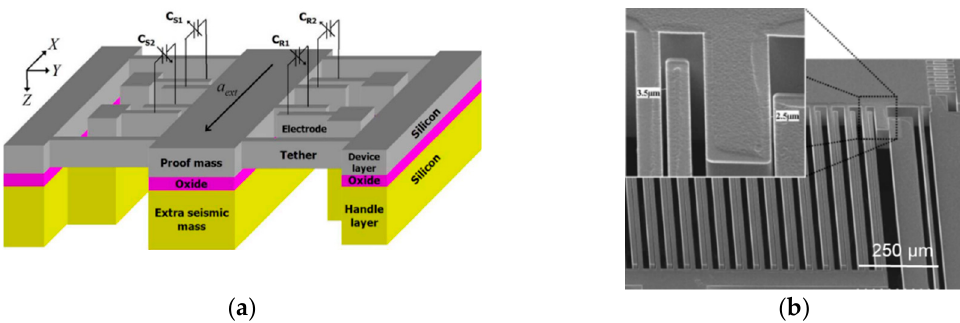
Figure 14. Schematic diagrams of the capacitive MEMS accelerometer with high AR capacitive gap values developed by Abdolvand et al. at Georgia Institute of Technology [62]: ( a ) the MEMS capacitive accelerometer; ( b ) highest gap aspect ratio of 40:1 at the shock-stop gaps.